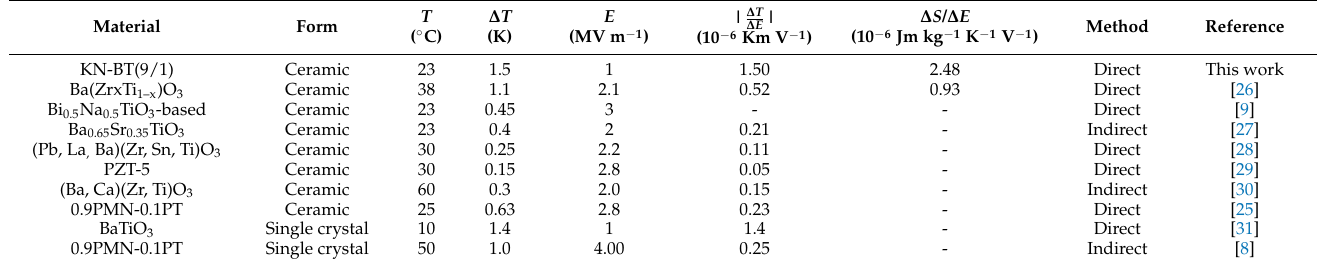
Table 1. ECEs of different ferroelectric ceramics with operating temperature near RT.